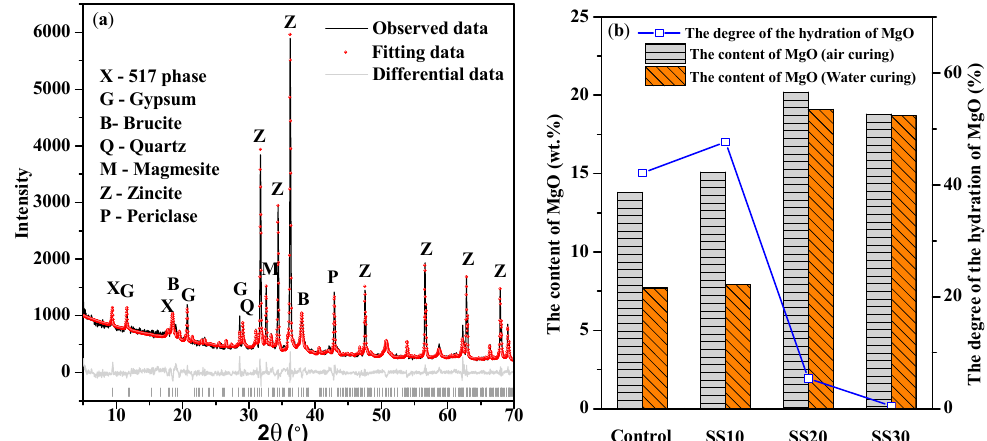
Figure 8. ( a ) Rietveld analysis plots of SS10 with CO 2 treatment after water immersion for 28 days and ( b ) the content of MgO in the control, SS10, SS20, and SS30 with CO 2 treatment before and after water immersion for 28 days.